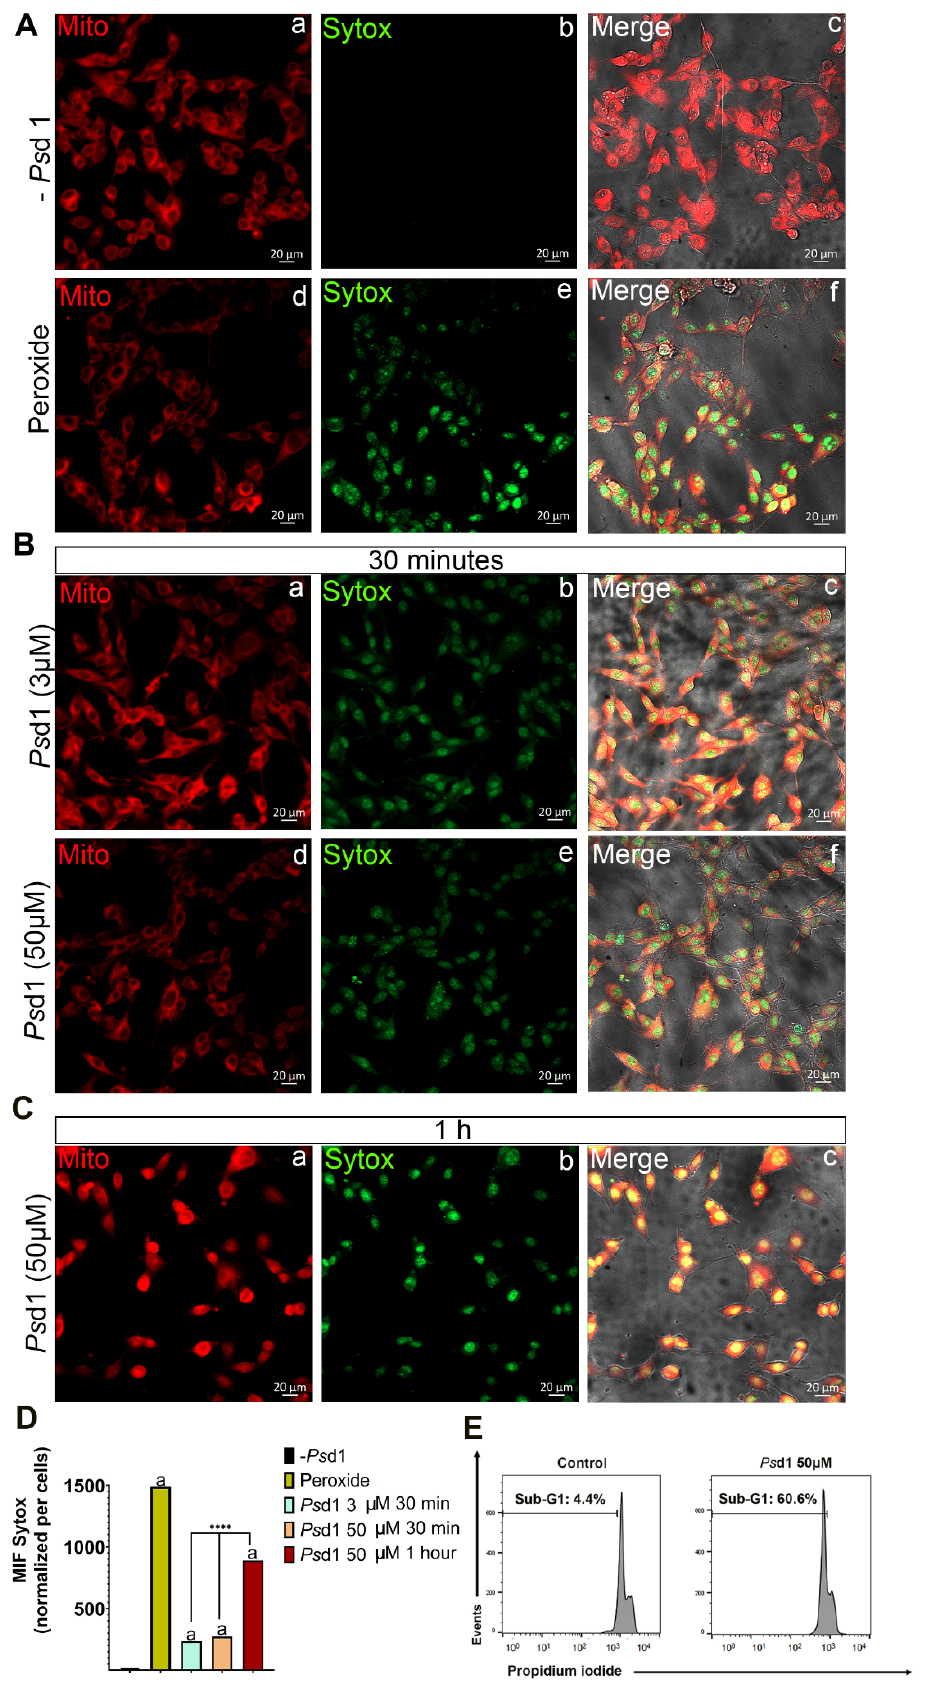
Figure 2. Ps d1 promotes B16F10 live cell membrane permeabilization as monitored by SYTOX Green fluorescence. ( A ) Ps d1 untreated and hydrogen peroxide-treated B16F10 cells. ( B ) A total of 1.5 × 10